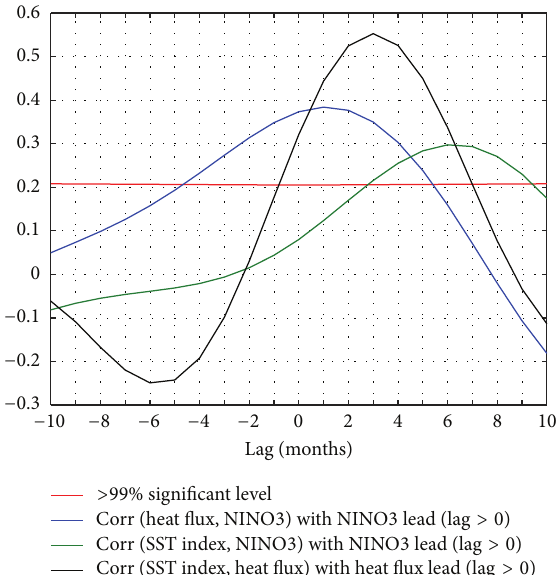
Figure 5: Lead and lag correlation between detrended spatial mean value of sea surface net heat flux anomaly and NINO3 SSTA index obtained from http://www.cpc.ncep.noaa.gov/data/indices/ ersst4.nino.mth.81-10.ascii (blue line; lag > 0 means NINO3 lead), between EMSC SST interannual index and detrended spatial mean value of sea surface net heat flux anomaly (black line; lag > 0 means heat flux lead), and between EMSC SST interannual index and NINO3 SSTA index (green line; lag > 0 means NINO3